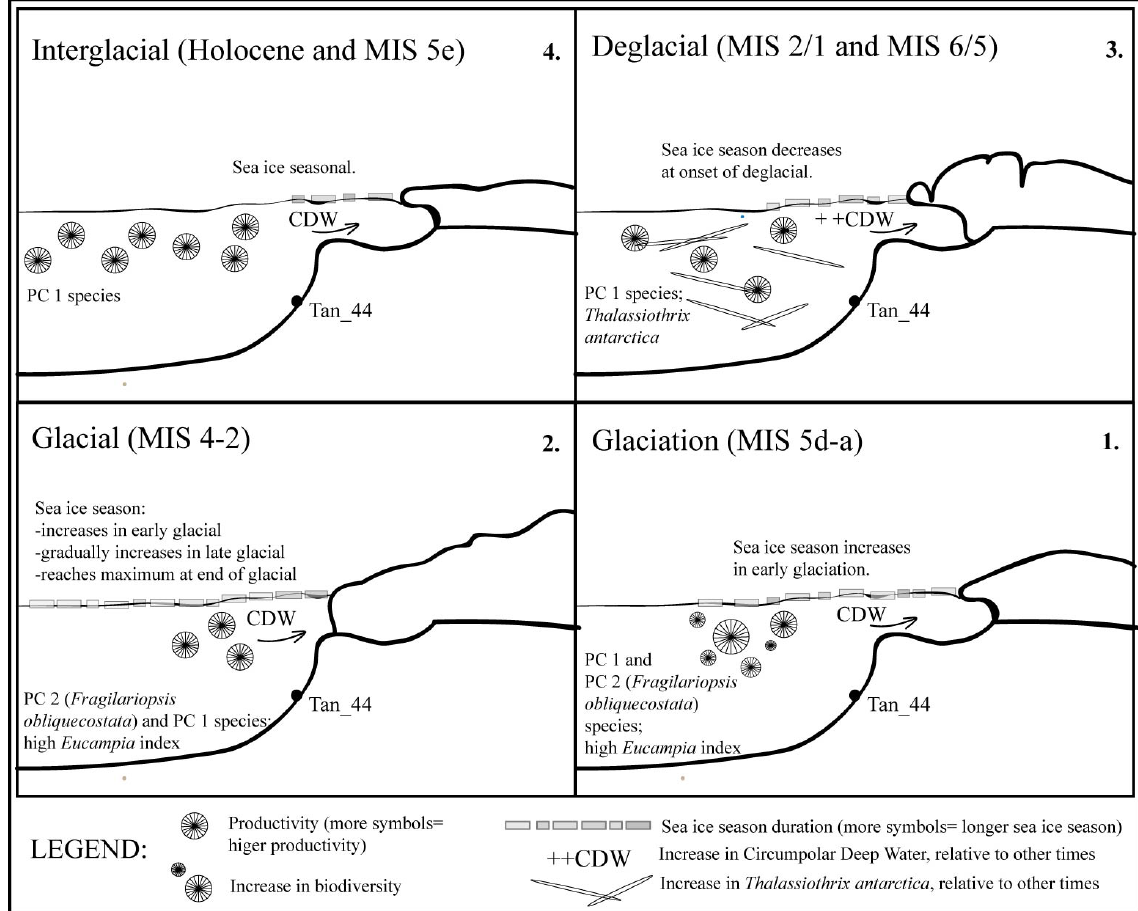
Figure 6. Sea ice and productivity interpretation across the last glacial cycle ( ∼ 140– ∼ 5ka) based on diatom assemblage variability. During the Holocene and MIS 5e interglacial periods, the seasonal sea ice at the site was similar to that of the present day. Sea ice duration initially increases, then decreases in glaciation (MIS 5d–a); and this also occurs in the early MIS 4–2 glacial. The sea ice then gradually increases during late MIS 4–2 glacial, reaching a maximum seasonal duration towards the end of the last glacial. During the deglacials (i.e., last two glacial-to-interglacial transitions), the influx rate of CDW increased relative to modern influx rates or other times, as suggested by the presence of the high-nutrient species, Thalassiothrix antarctica . This study suggests the sea ice decreased at the end of the last glacial and that the increase in CDW influx occurred after the sea ice season declined, during the last deglacial. Yet, all of this occurred before the onset of the last major ice sheet